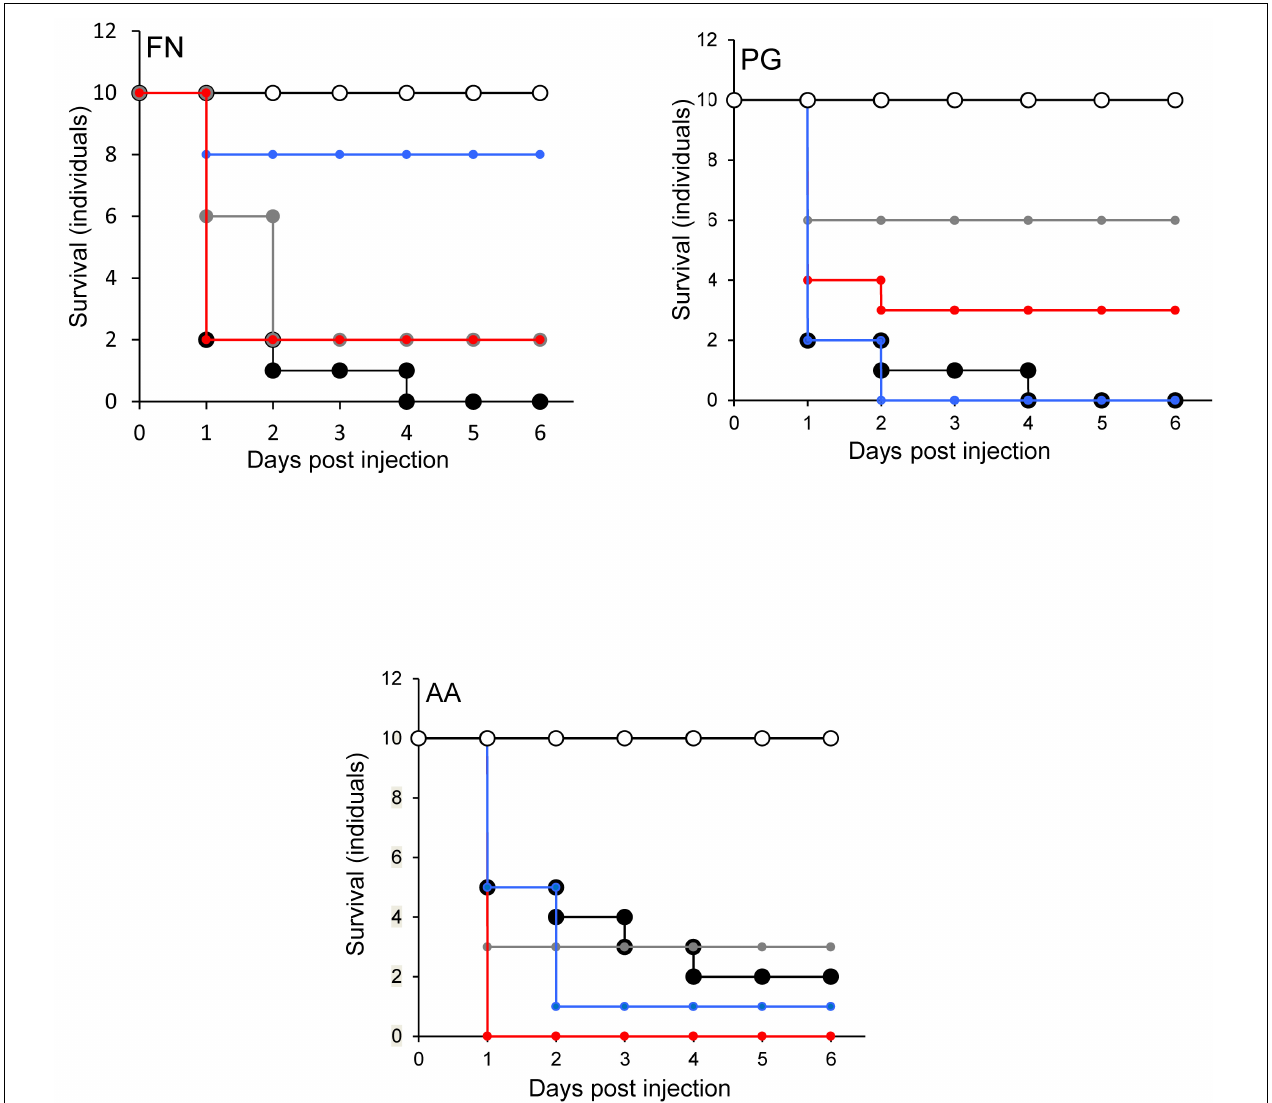
FIGURE 5 | Protection of larvae conferred by candidate probiotics following simultaneous administration of periodontal pathogens into the same larval proleg. Pathogen only (black symbols) and PBS (white symbols). Pathogen administered simultaneously with L. rhamnosus (gray symbols), L. reuteri (red symbols), S. salivarius (blue symbols). All experiments were done twice on 2 consecutive weeks, with different batches of larvae and with three replica plates where each plate contains 10 larvae. S. salivarius K-12 had a protective effect ( p ≤ 0.01) when administered simultaneously with F. nucleatum but not for A. actinomycetemcomitans or P. gingivalis . L. reuteri conferred protection against P. gingivalis, limited protection against F. nucleatum, and was not protective against A. actimomycetemcomitans . L. rhamnosus GG had some protective effect on larvae when was injected with F. nucleatum and P. gingivalis but reduced the larval viability when injected combined with A. actinomycetemcomitans.